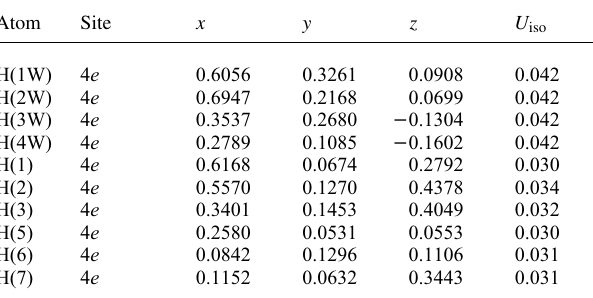
Table 2. Atomic coordinates and displacement parameters (in Å 2 )